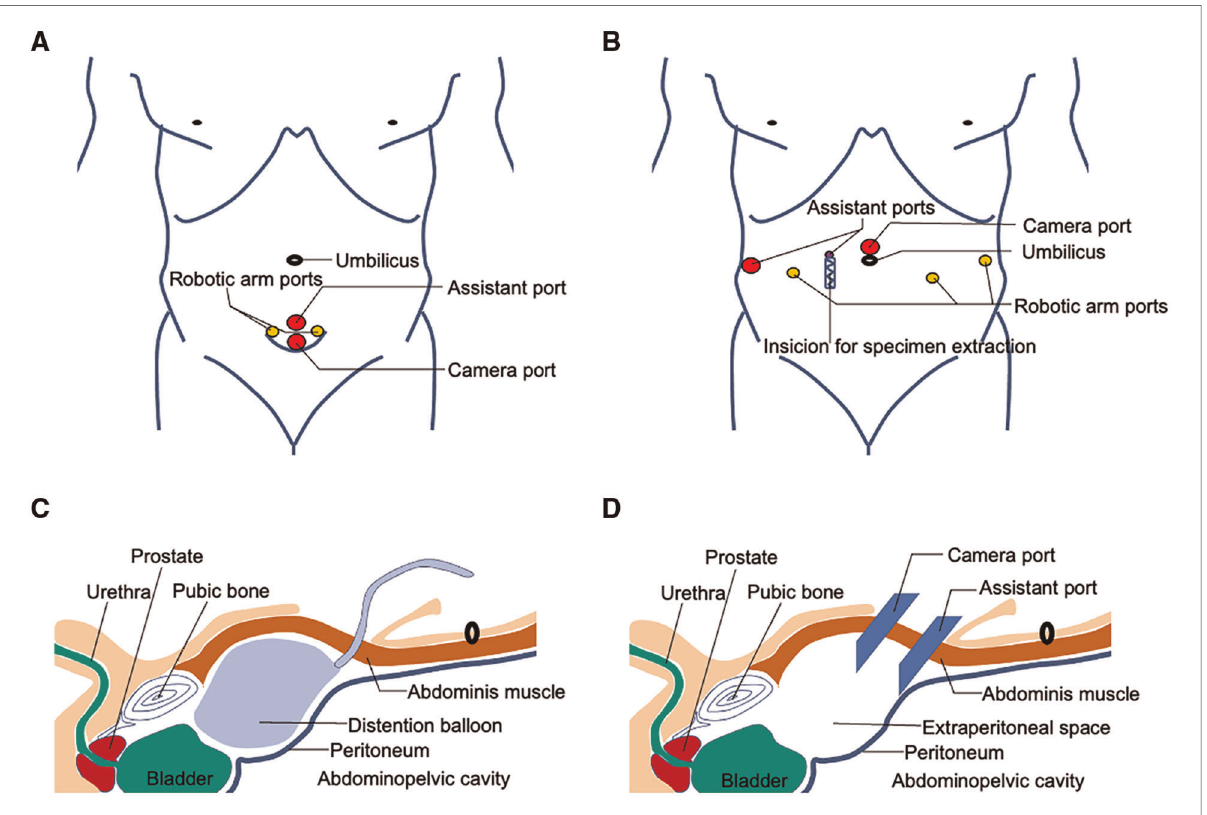
FIGURE 1 Schematic view of skin incision, extraperitoneal space creation, and port placement of ssmpRARP: ( A ) Trocar placement for ssmpRARP; ( B ) Six-port conventional multiport approach for RARP; ( C ) Extraperitoneal space creation using a distension balloon; ( D ) Extraperitoneal space access and trocar placement for